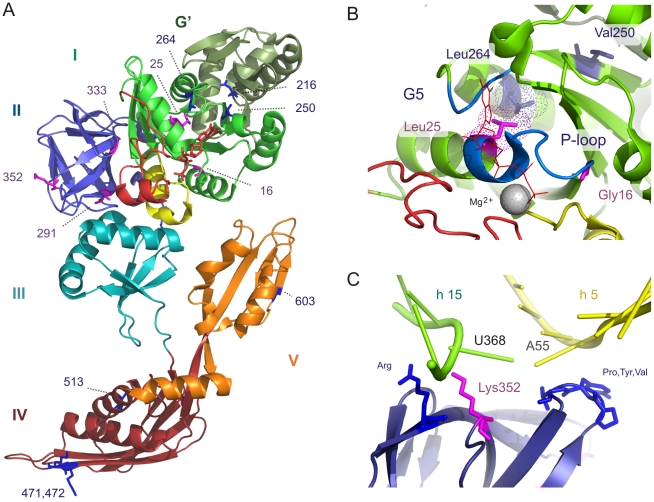
The EFG structure and location of type I and type II conserved positions.(A) The EFG structure (1WDT) is shown as ribbon colored by domain: domains I, II, III, IV, and V are colored green (with the G′ olive green), blue, cyan, ruby and orange, respectively. Switch I is red and switch II is yellow. The bound GTP is red and Mg2+ is shown as a grey ball. Location of type I - (violet) and type II (blue) conserved positions are shown in the structure. (B) Type I – and type II conserved positions in the GTPase domain. The Leu25 (violet stick) and its conserved interaction partner Leu264 (blue stick) from a conserved hydrophobic contact. P-loop and G5 motif are colored blue. (c) Lys352 (violet stick) is in close proximity to 16S rRNA helix 15 uridines 367 and 368. Panels a, and b are based on the EFG II structure of Thermus thermophilus 1WDT. For panel c the structure 2OM7 we used, which was obtained from EM studies and EFG fitting by Connelle et al. [22].